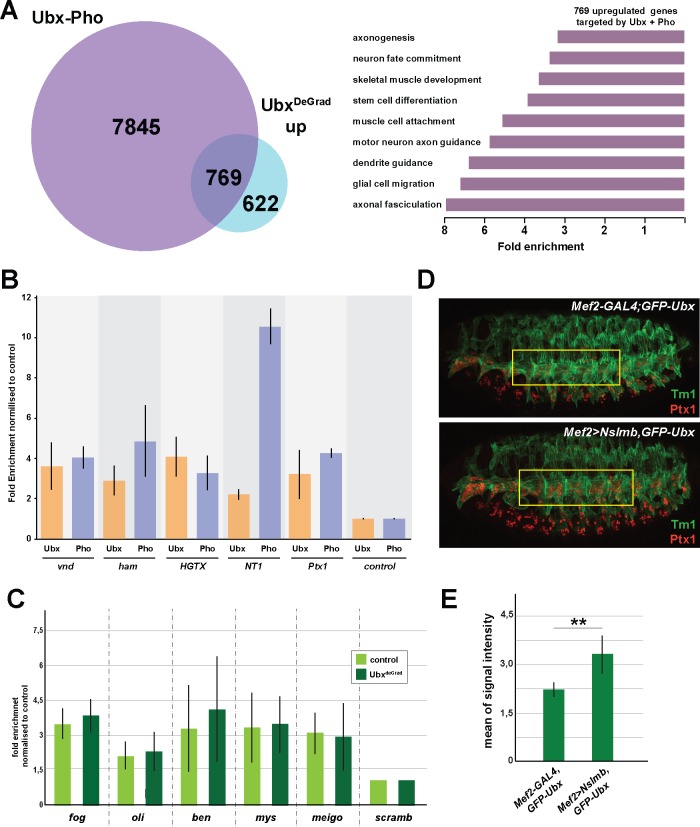
Ubx interacts with Pho at inactive genes encoding alternative fate genes.(A) Left Panel: Venn diagram representing the overlap between genes up-regulated in Ubx depleted mesodermal nuclei (light blue) and genes associated with overlapping Ubx and Pho peaks (Ubx-Pho) (purple). Right panel: Fold enrichment of gene ontology terms of the 768 genes, which are bound by Ubx and Pho and are up-regulated in Ubx depleted mesodermal nuclei. (B) ChIP-qPCR experiments of Ubx and Pho using chromatin from stage 14–17 w1118 and twi-INTACT sorted nuclei, respectively. Genomic regions related to the genes vnd, HGTX, Ptx1, ham and NT1 are analyzed using the same primer pairs in close proximity (200 bp), the scramb1 locus is used as control. (C) ChIP-qPCR experiments of Pho detecting chromatin regions close to the fog, oli, ben, mys and meigo genes bound by Pho but not Ubx and chromatin isolated from UAS-Nslmb,GFP-Ubx (light green) and Mef2 >Nslmb,GFP-Ubx (dark green) mesodermal nuclei. As control locus, an exon region in the scramb genes was used, which is not bound by Pho or Ubx. (D) Lateral view of stage 16 Mef2-GAL4,GFP-Ubx and Mef2 >Nslmb,GFP-Ubx embryos stained for the muscle marker Tm1 and Ptx1 protein. The yellow boxes highlight the lateral muscles. (E) Quantification of Ptx1 signal intensities in the lateral muscles (as indicated by the yellow boxes) in Mef2-GAL4,GFP-Ubx and Mef2 >Nslmb,GFP-Ubx embryos, showing that the expression of Ptx1 is significantly increased in comparison to control embryos (**=p < 0.01).